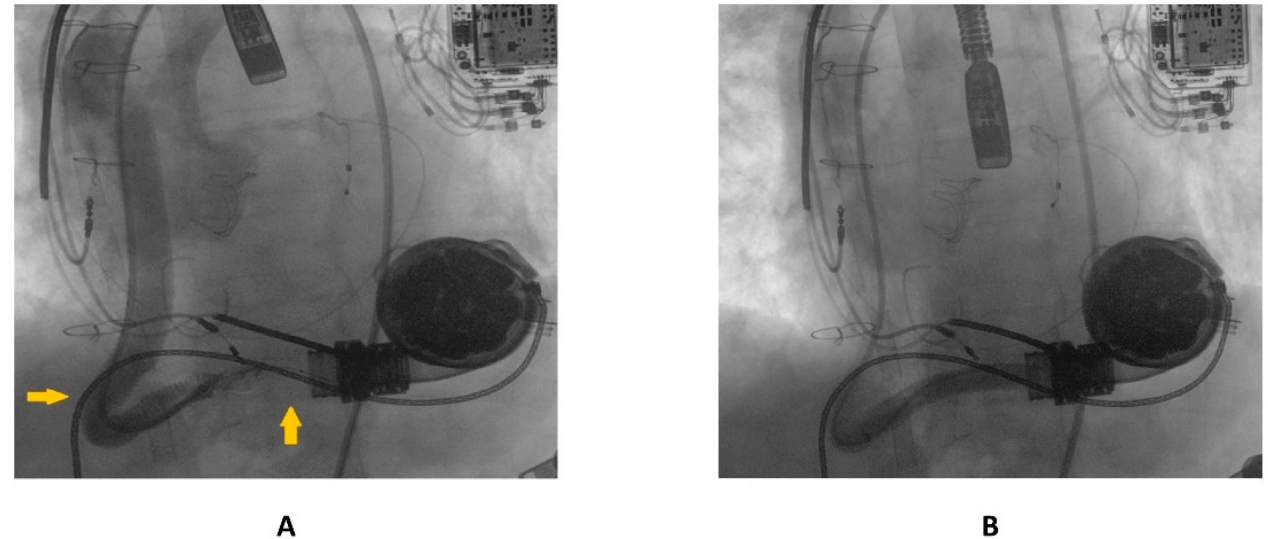
Figure 1. ( A ) preprocedural angiography of the first outflow graft obstruction episode (yellow arrows highlighting the kinking site and proximal thrombosis location); ( B ) result following the first percutaneous intervention.